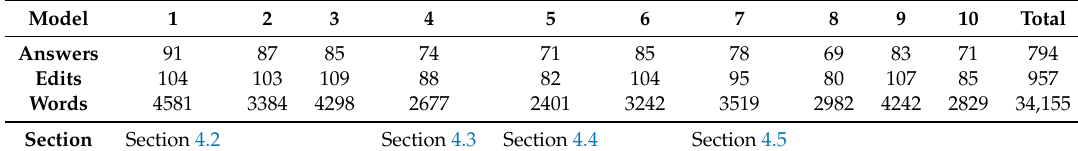
Table 4. General statistical data from the